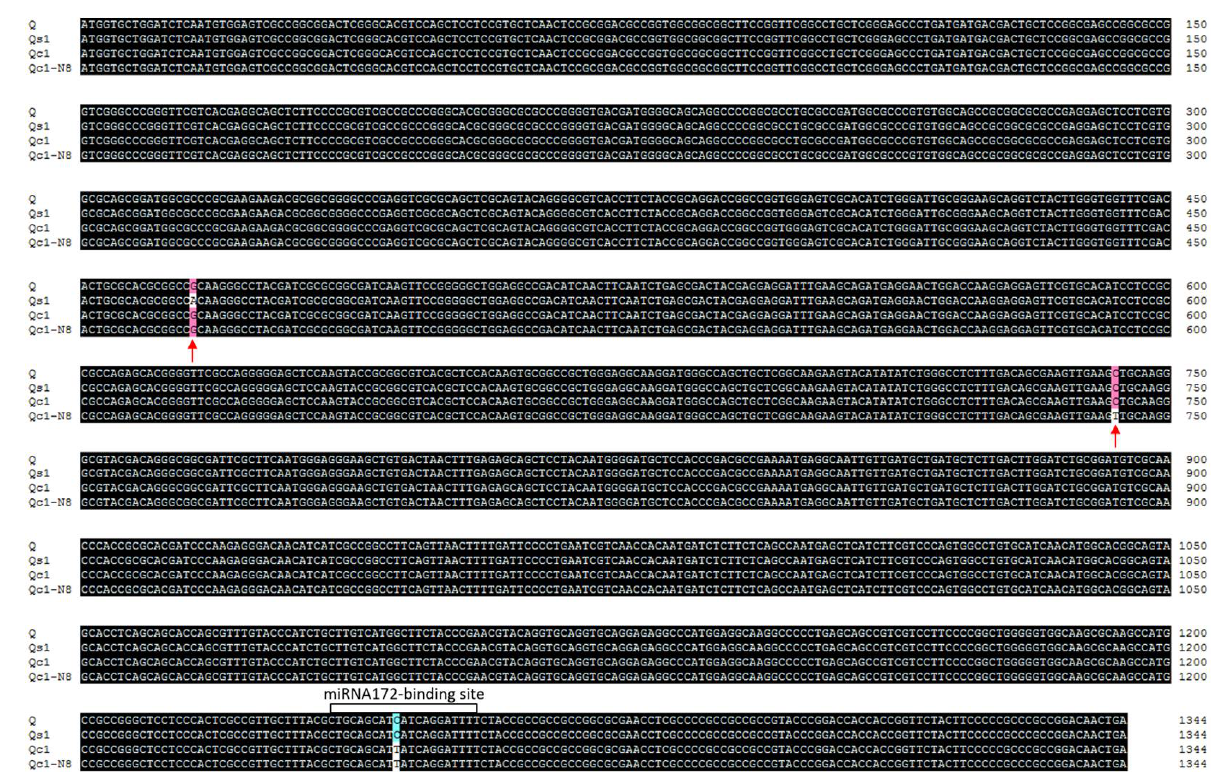
Figure 3. Alignment of the Q (GenBank No. KX580301.2), Q s1 (OK041024), Q c1 (KX580302.2), and Q c1 -N8 (OK041023) open reading frames. The red arrows indicate the two specific missense mutations in the Q s1 and Q c1 -N8 alleles. The microRNA172-binding site is boxed. Table 1. Comparison of the agronomic traits of the mutant ss1 and the wild-type (WT)